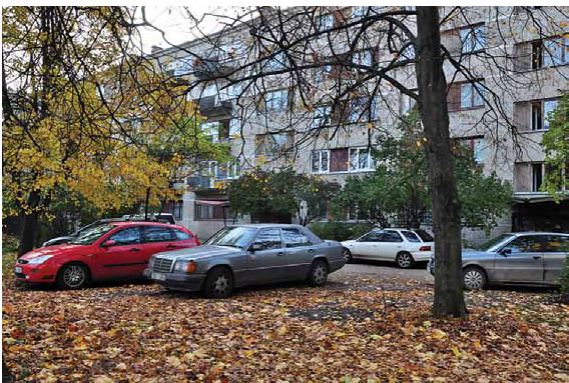
Fig. 2. Traditional usage of green open areas